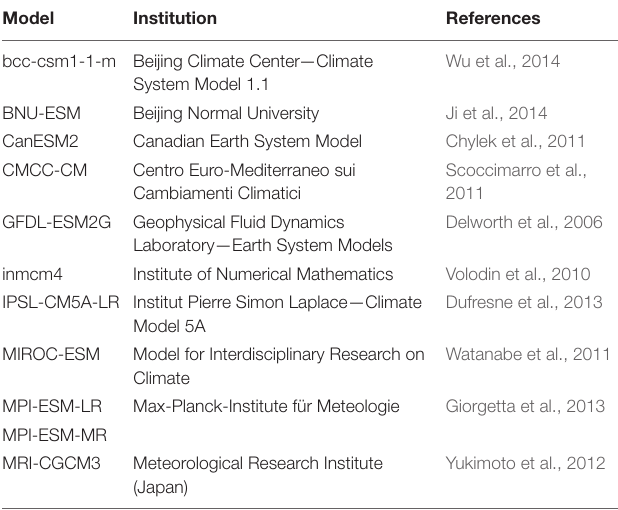
TABLE 1 | List of global climate models used in this